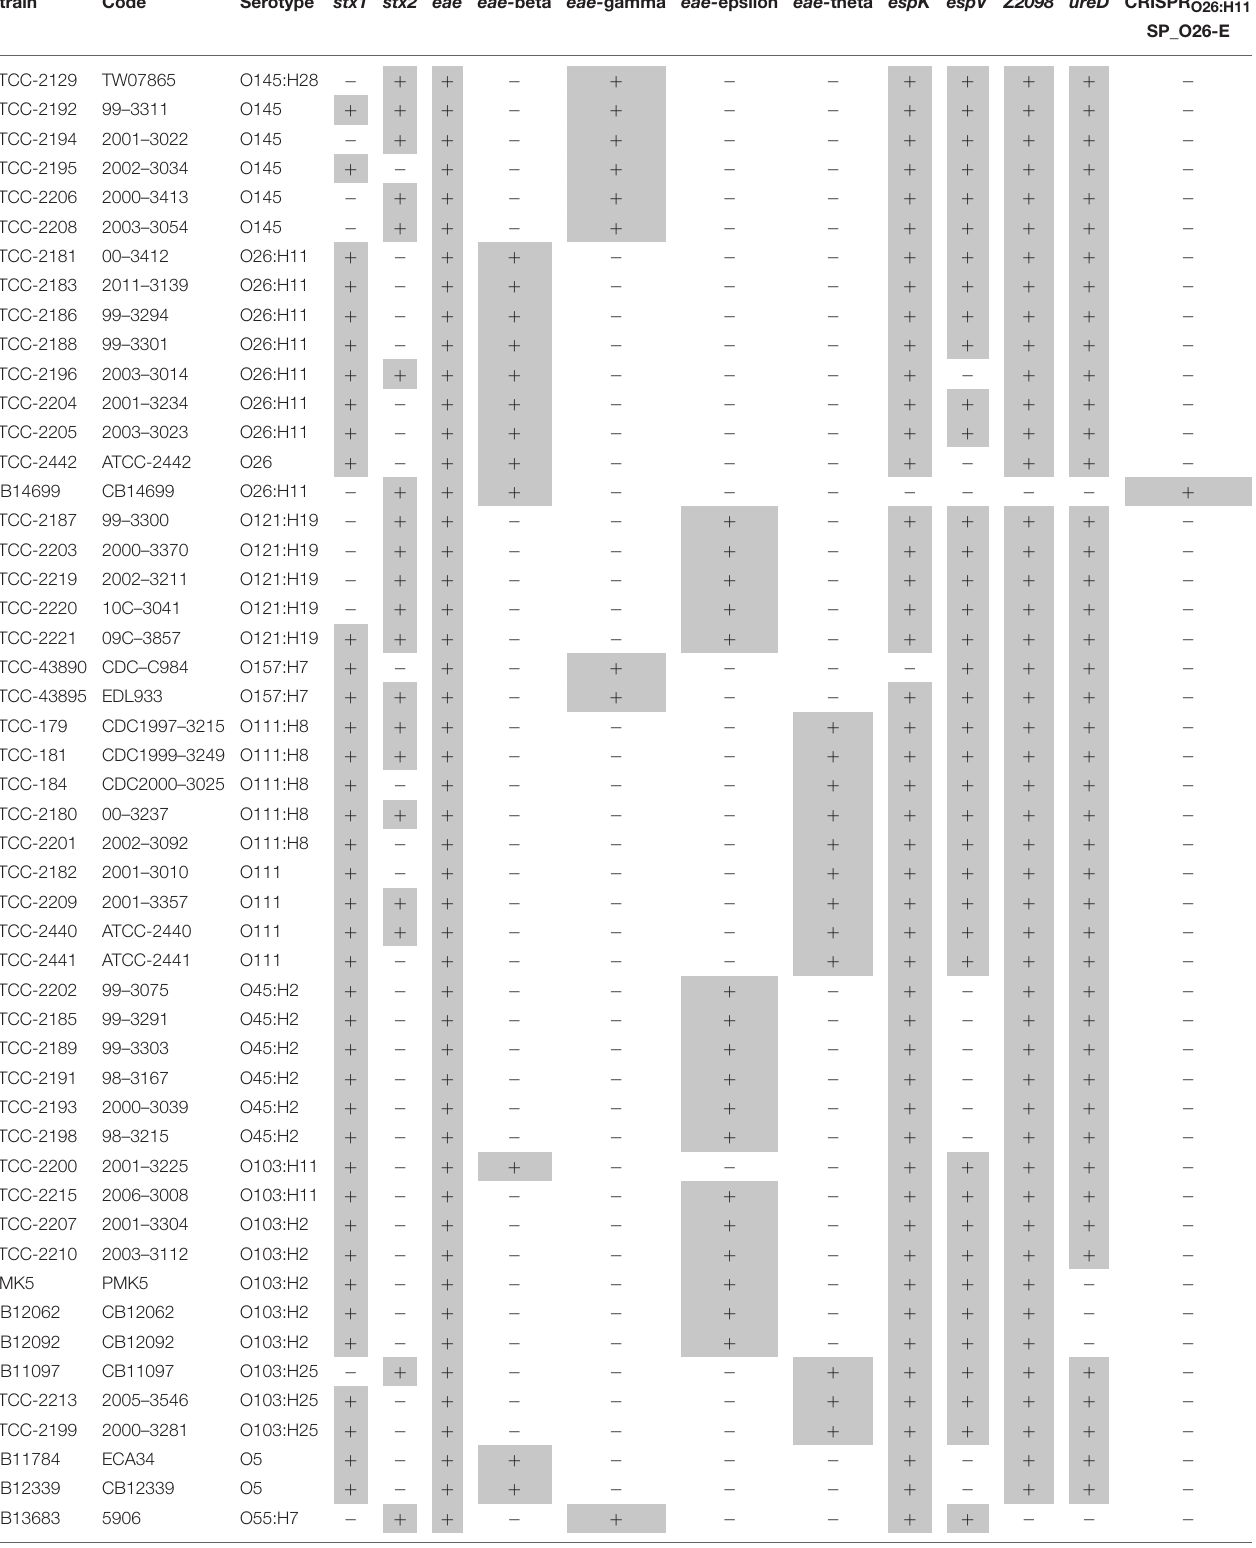
TABLE 1 | PCR-screening of the genetic markers in STEC isolates used as reference. Strain